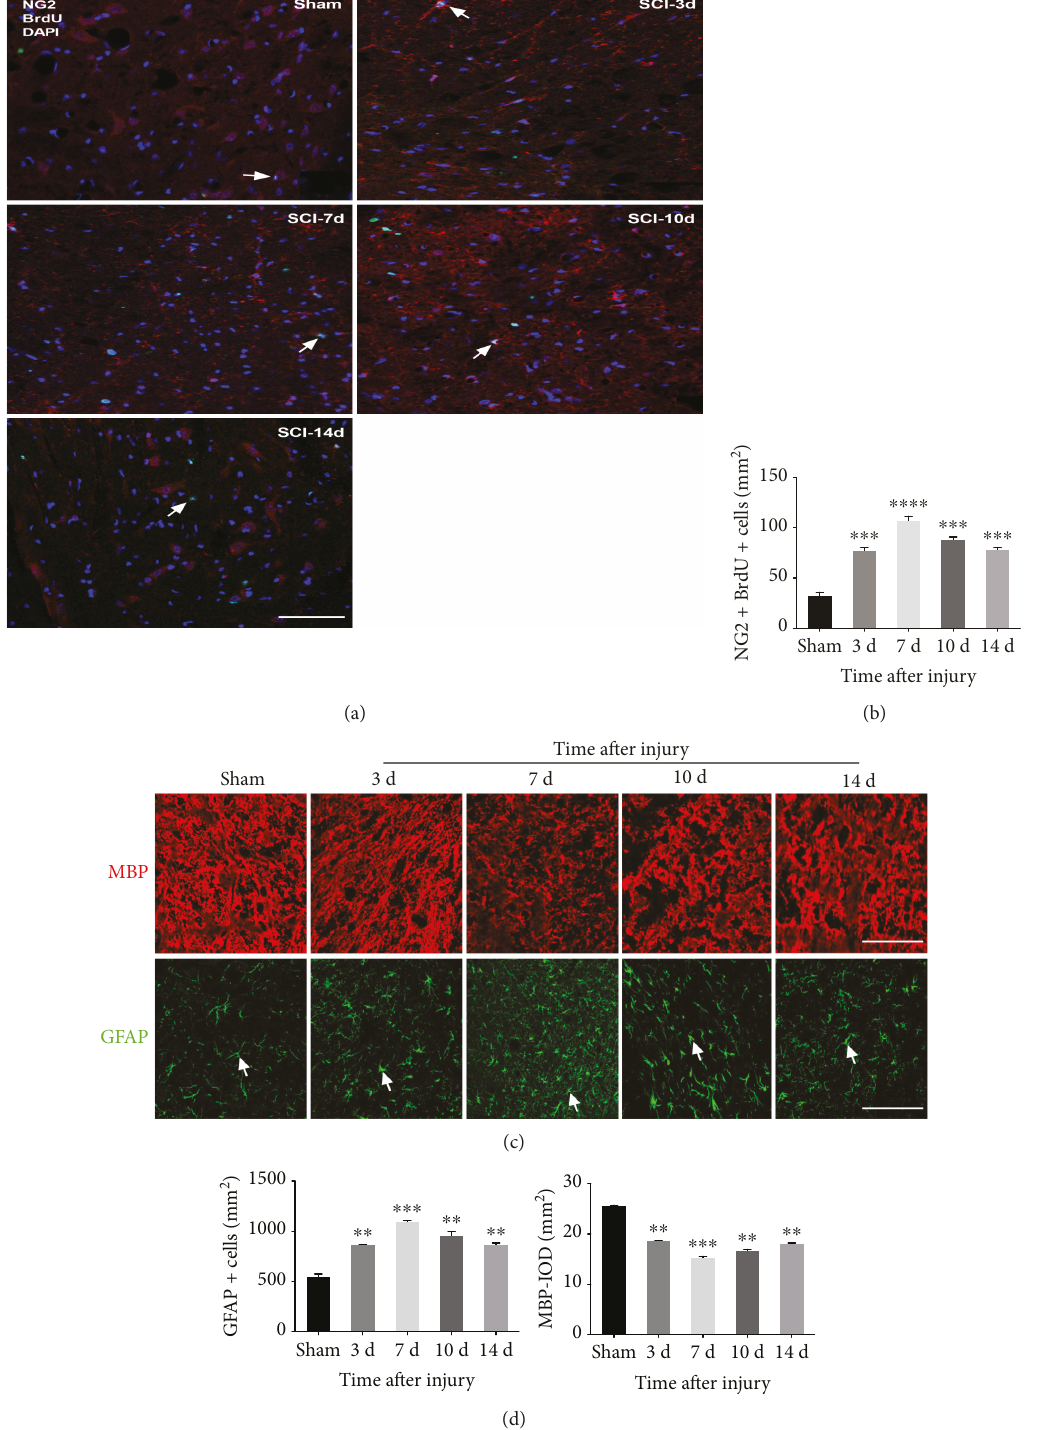
Figure 2: Dynamic changes in NG2+ with BrdU+ OPCs, MBP+ oligodendrocytes, and GFAP+ astrocytes after contusion SCI. (a, c) Representative immunostained images of NG2 positive (red) with BrdU positive (green) cells, MBP positive (red) cells, and GFAP positive (green) cells, respectively, between the sham and SCI group. (b, d) Quantitative data of NG2+ with BrdU+ OPCs, MBP+ oligodendrocytes, and GFAP+ astrocytes, respectively, between the sham and SCI group. ∗∗ p < 0 01 , ∗∗∗ p < 0 001 , and ∗∗∗∗ p < 0 0001 . Scale bar =50 μ m. OPCs: oligodendrocyte precursor cells; MBP: myelin basic protein; GFAP: glial fi brillary acidic protein; BrdU: